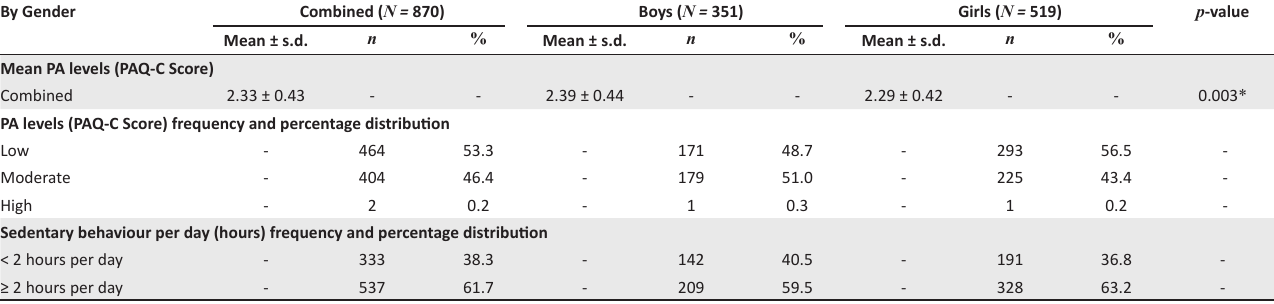
TABLE 1a: Summary levels, frequencies and percentages of physical activity (PA) and sedentary behaviour classifications by gender. By Gender